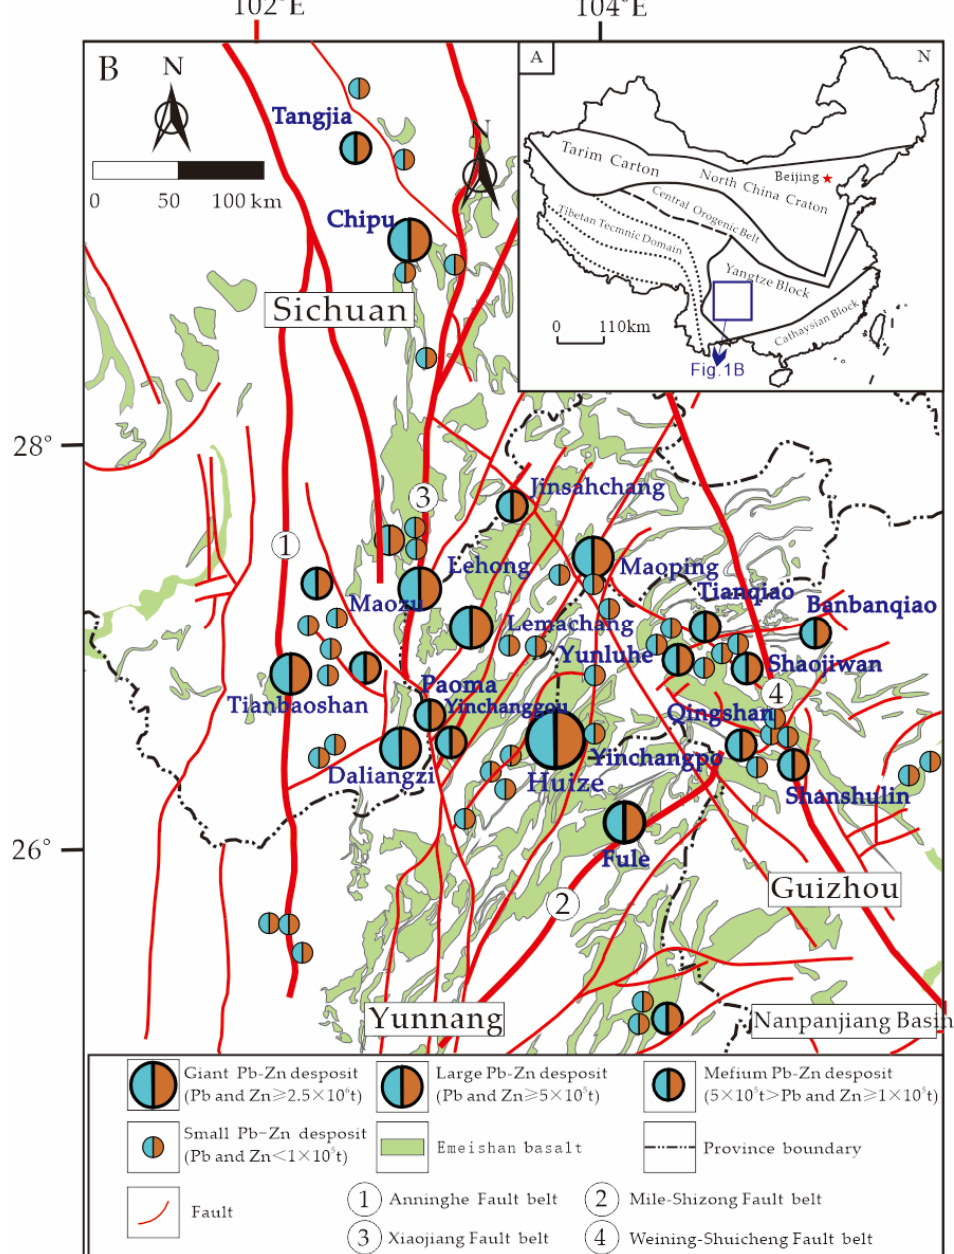
Figure 1. ( A ) Simplified tectonic map of South China (modified from [27]); ( B ) regional geological map of the Sichuan–Yunnan–Guizhou Pb–Zn triangle area (modified from [26]). The lead–zinc deposits in this area are characterized by strata of multiple ages, but the location distribution is relatively concentrated, primarily in the northwest Guizhou, northeast Yunnan and southeast Sichuan regions [28]. The Pb–Zn deposits developed in the Sinian to Triassic strata (Table 1) and are concentrated in the carbonate strata. The ore-bearing stratigraphic lithology is mainly dolomite [2] and partly dolomitic limestone, in which large and medium-sized Pb–Zn deposits are located (Table 1). The controlling effect of lithology on the mineralization is